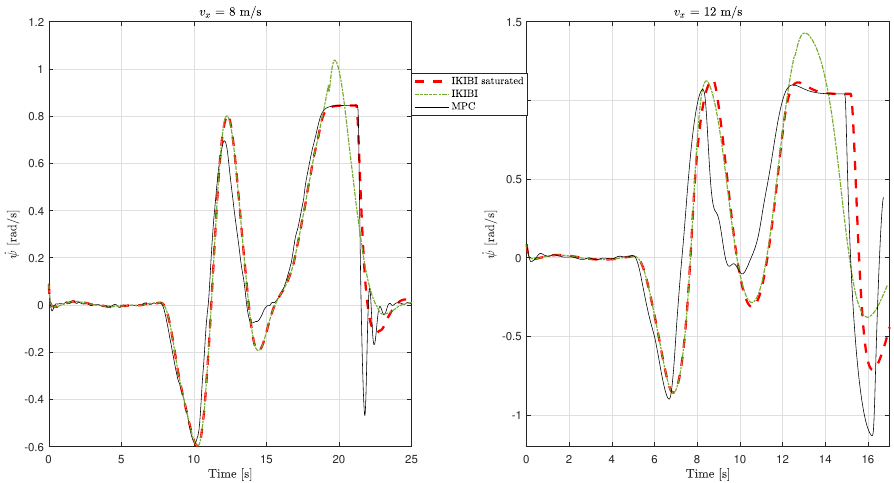
Figure 5. Yaw rate temporal evolution: noiseless, fast sensor feedback test. ( left ) v x = 8 m/s and ( right ) v x = 12 m/s.